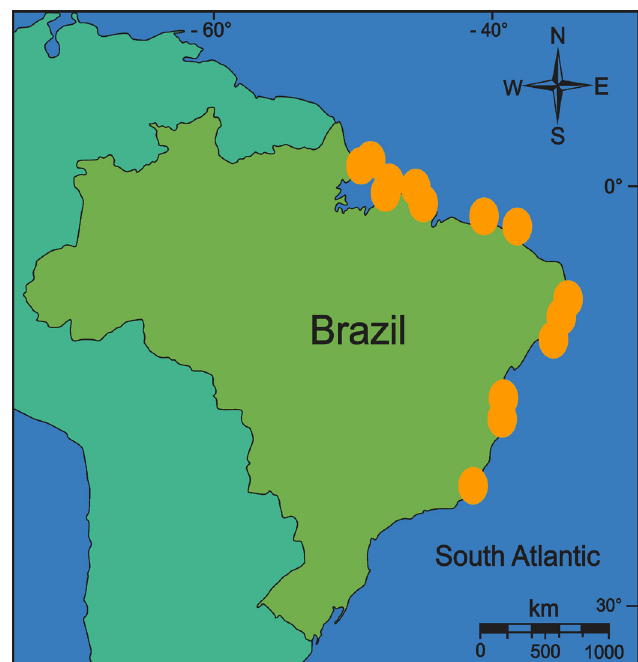
Figure 10. Distribution of Excorallana oculata (Hansen, 1890) for Brazilian